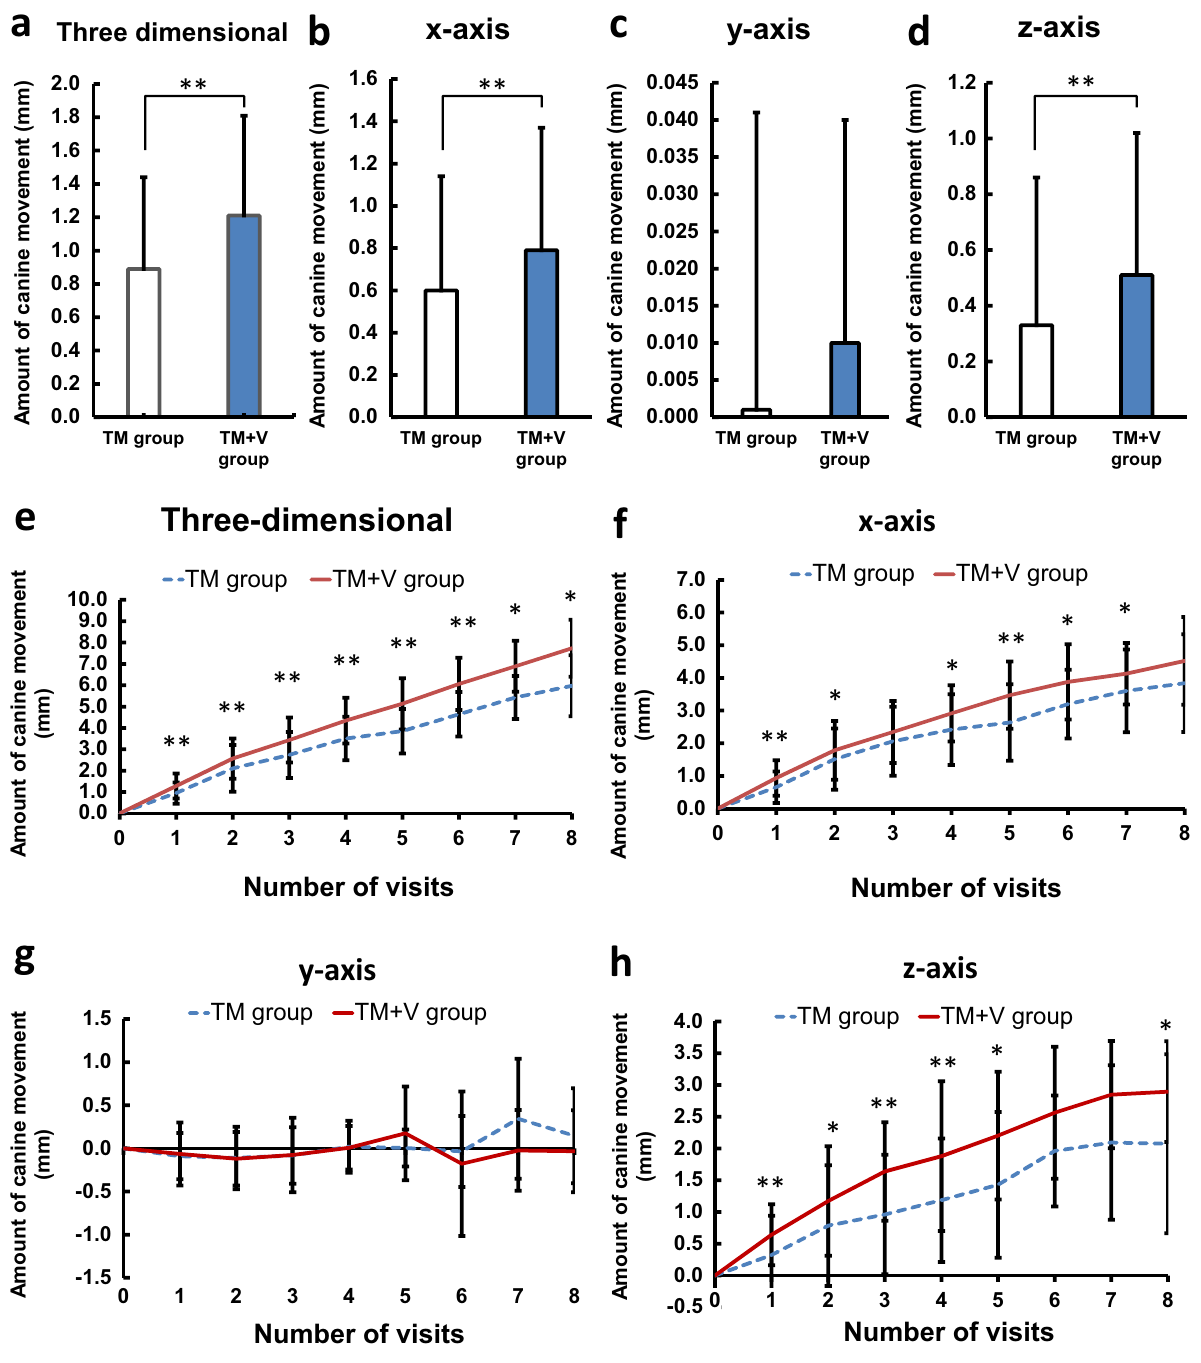
Figure 2. Amount of canine movement. (a) Amount of three-dimensional movement of canine. (b–d) Amount of canine movement on each coordinate axis. (b) Amount of canine movement on x-axis. (c) Amount of canine movement on y-axis. (d) Amount of canine movement on z-axis. (e) Amount of canine movement for each visit. (f–h) Amount of canine movement for each visit on coordinate axis. (f) Amount of canine movement for each visit on x-axis. (g) Amount of canine movement for each visit on y-axis. (h) Amount of canine movement for each visit on z-axis. *P < 0.05, **P <